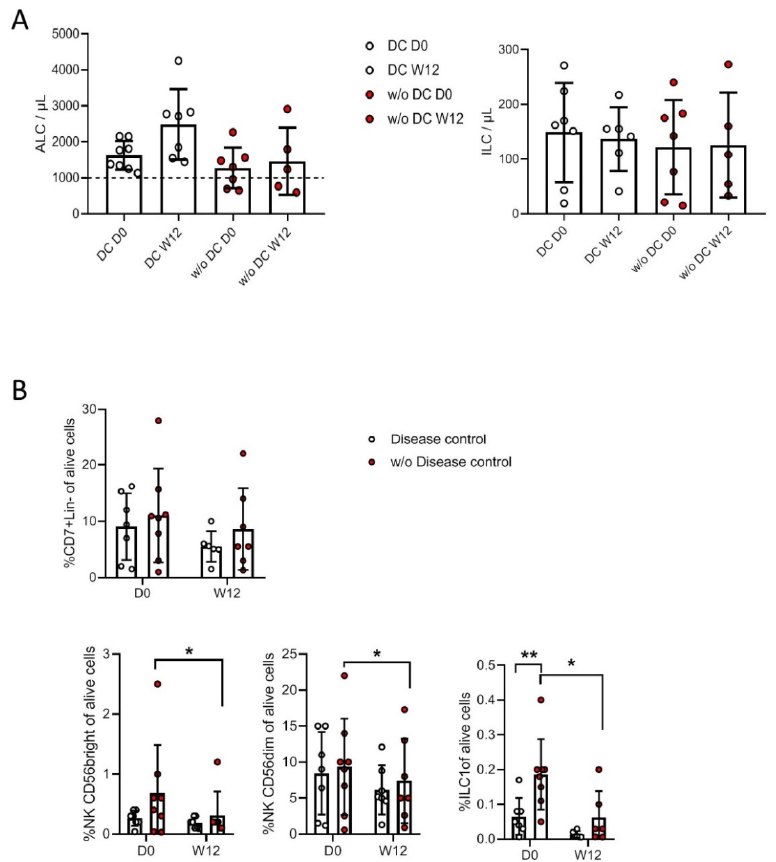
Figure 4. Assessment of ILC subsets in patients with disease control (DC) and in patients without disease control (w/oDC). Absolute lymphocyte counts (ALC) and absolute ILC counts per µL in DC and w/oDC patients ( A ). Percentages of lin - CD7 + ILC, CD56 bright , CD56 dim , and ILC1 in live PBMCs from DC and w/oDC patients ( B ). A Wilcoxon matched-pair signed rank test was used to compare the percentages in patients with DC between D0 and other times of treatment. A Mann– Whitney test was used to compare the percentages between DC and w/oDC patients (* p < 0.05, ** p < 0.01).